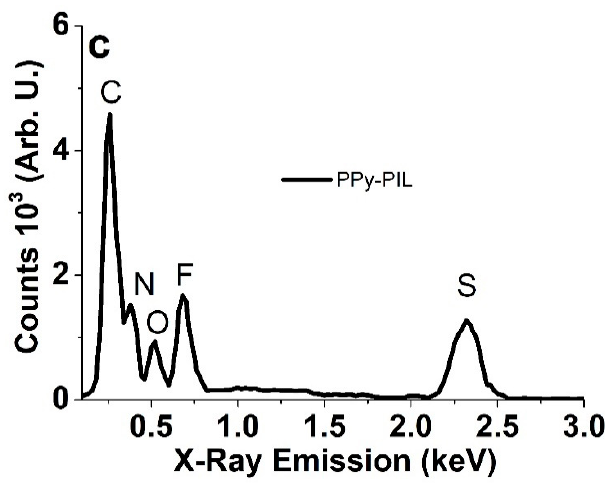
Figure 1. ( a ) Chronopotentiogram of PPyPIL galvanostatic synthesis, ( b ) SEM image of PPyPIL surface (scale bar 10 µ m) with cross-section as an inset (scale bar 3 µ m) and ( c ) EDX spectrum of PPyPIL film directly after polymerization (oxidized state). PPy, polypyrrole; PIL, polymerizable ionic liquid; EDX, energy dispersive X-ray spectroscopy.